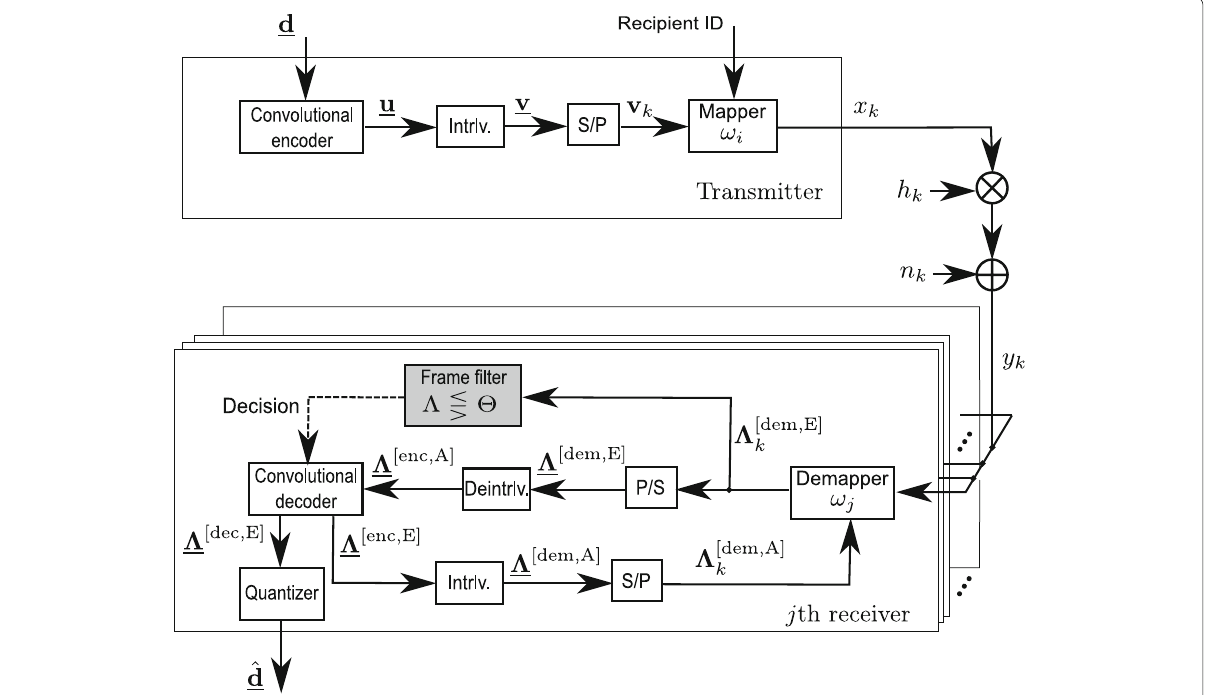
Fig. 1 Block diagram of evaluated BICM-ID system with